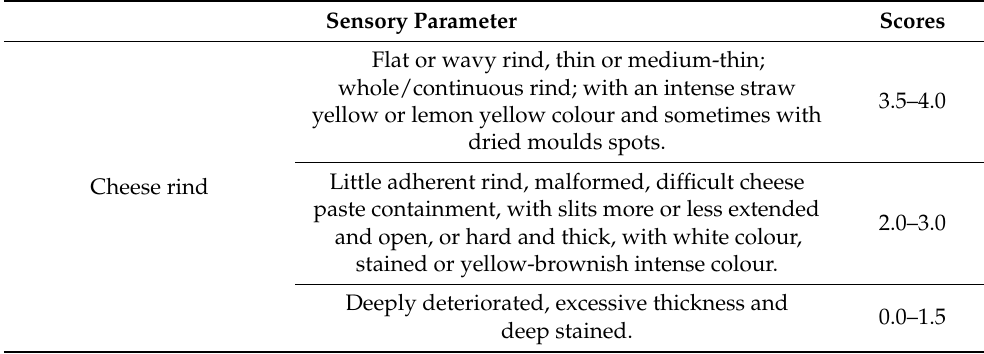
Table 1. Sensory parameters in Serpa PDO cheese certification [6]. Sensory Parameter Scores Flat or wavy rind, thin or medium-thin; whole/continuous rind; with an intense straw yellow or lemon yellow colour and sometimes with dried moulds spots. Cheese rind paste containment, with slits more or less extended and open, or hard and thick, with white colour, stained or yellow-brownish intense colour. deep